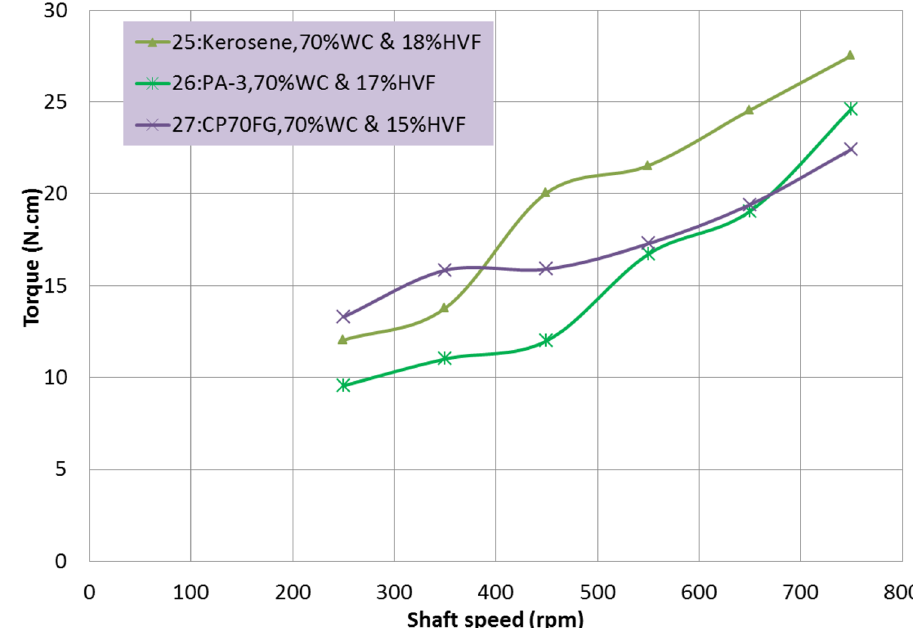
Fig. 19 Average torque values collected from Zone IV for the non-AA tests. AA anti-agglom- erant, WC watercut,